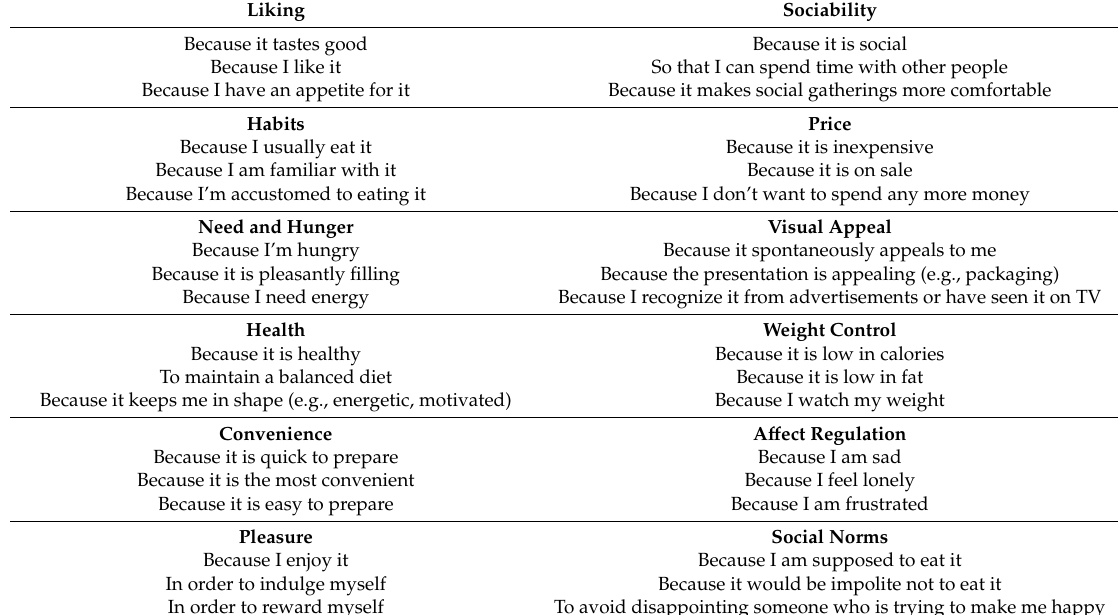
Table 1. The 16 eating motivation constructs ( bold ) and their corresponding positive subitems that were used in the eating motivation survey (EMS) (adapted from